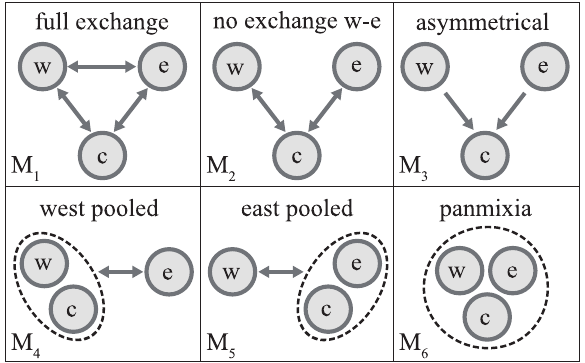
Figure 2. Migration models compared in the Migrate analysis of the Northern Indian Ocean sister-species. Migration models range from M 1 : full exchange to M 6 : panmixia. west (w), east (e) and central (c) represent the regional groupings displayed in Fig. 1; arrows indicate direction of migration.